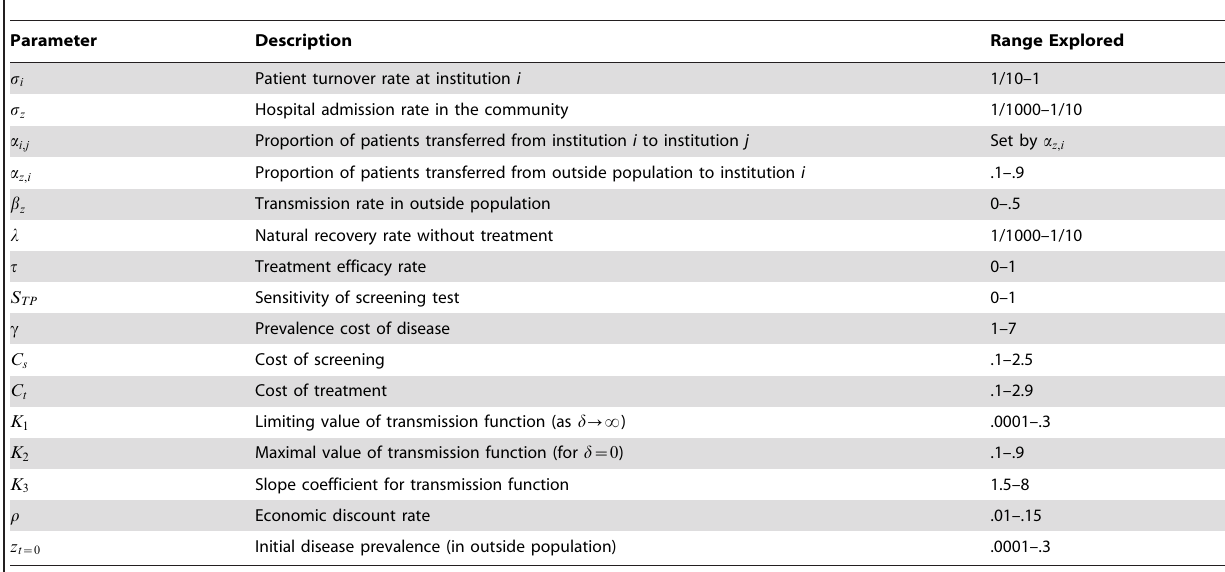
Table 1. Model parameters and range of values